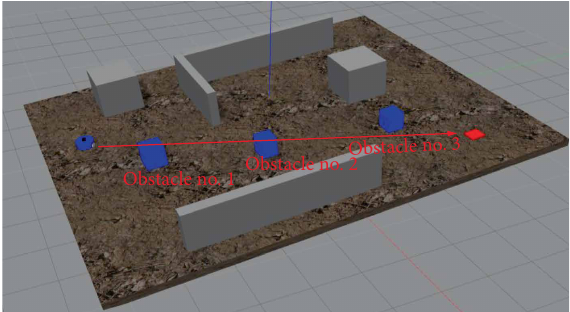
Figure 13: Actual dynamic slope environment.